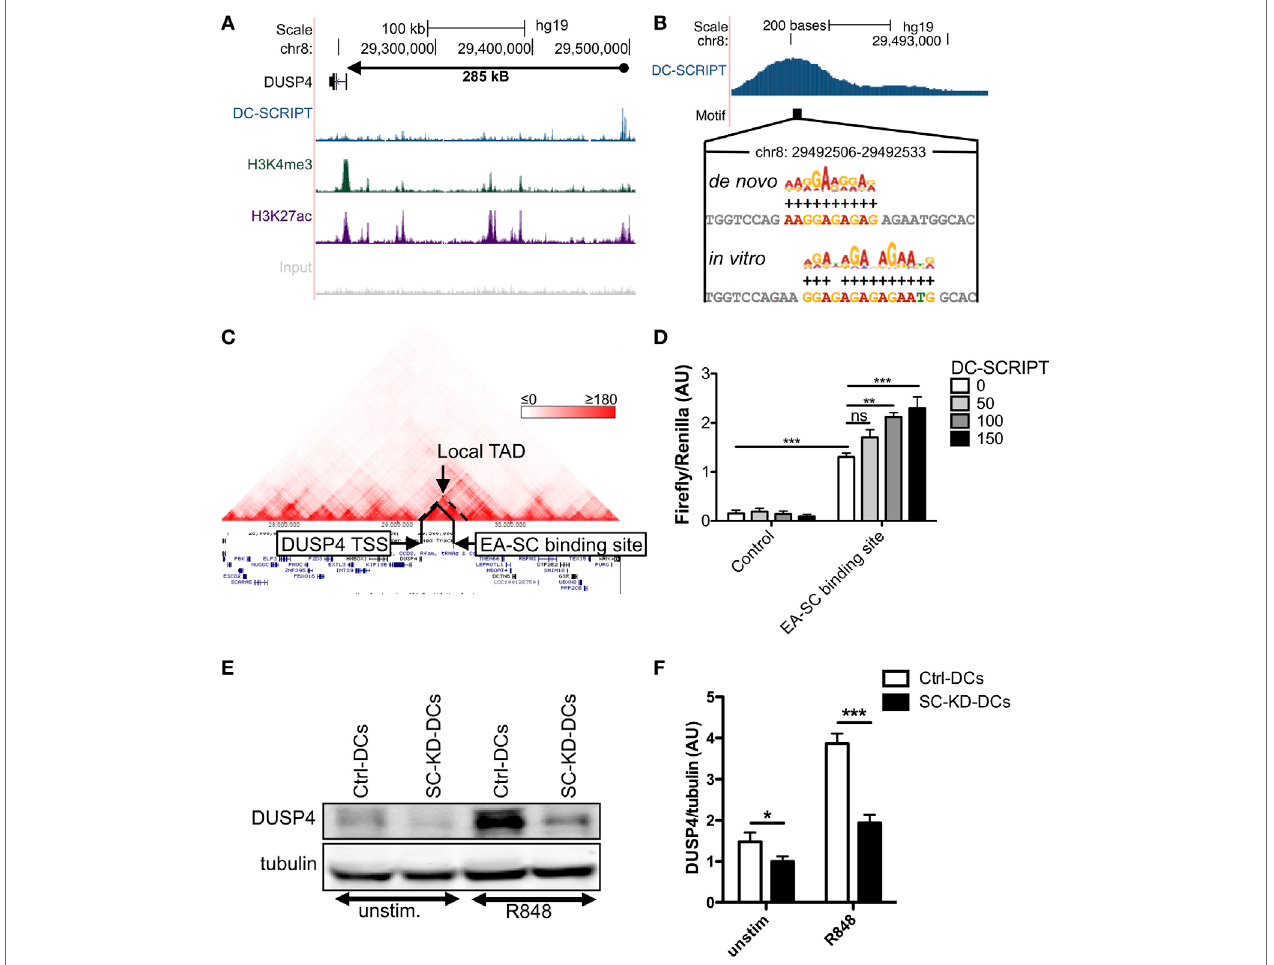
FigUre 3 | DC-SCRIPT enhances dual-specificity phosphatase (DUSP)4 expression. (a,B) DUSP4 EA-SC binding site track from UCSC Genome Browser. (a) The tracks from top to bottom show the DUSP4 gene annotation, and the ChIP-Seq signal for DC-SCRIPT (blue), H3K4me3 (green), H3K27ac (purple), and input (gray). (B) Position of the GA-rich motifs identified de novo from this ChIP-Seq dataset or in vitro by cyclic amplification and selection of targets. (c) Topological associated domain (TAD) analysis was done using the Hi-C data browser from the Yue-lab at Penn State (http://promoter.bx.psu.edu/hi-c) containing data from Ref. (41–43). Highlighted in the figure is a local TAD that only contains the DUSP4 gene, and the EA-SC binding site. The example shown is from GM12878 (lymphoblastoid B cell line). (D) Luciferase assays with DUSP4 promoter-containing vector with either genomic DNA containing the DUSP4 gene-associated EA-SC binding site, or a control piece of DNA located in between the binding site and the DUSP4 TSS of similar length. Some conditions were cotransfected with increasing amounts of a DC-SCRIPT expression vector or corresponding amount of empty vector. Firefly luciferase is presented relative to TK renilla luciferase control ( n = 3, mean + SEM). Statistics: ANOVA with Bonferroni post test. (e,F) Protein expression level of DUSP4 in unstimulated or 6 h R848-stimulated Ctrl-DCs and SC-KD-DCs ( n = 7, mean + SEM). Statistics: Student’s paired t test. ** p < 0.01, *** p <